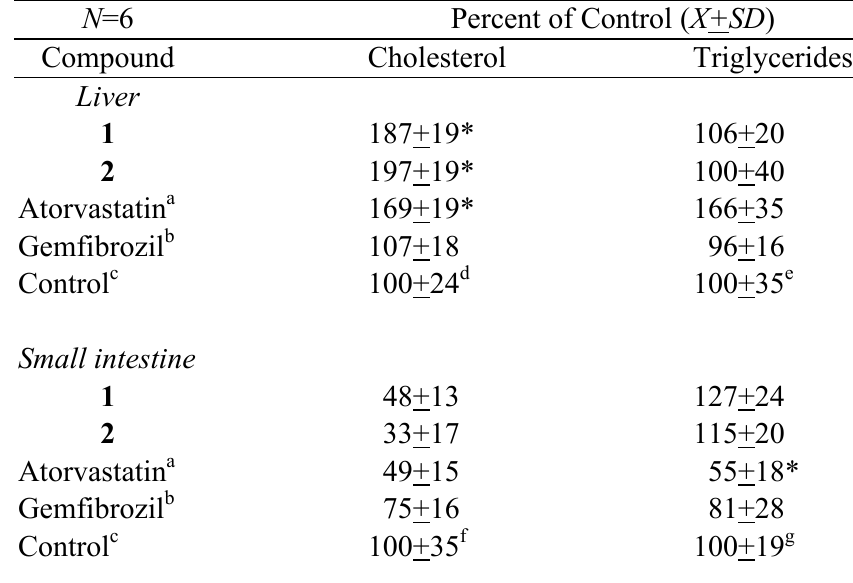
Table 3: The effects of the 2,3,4-trisubstituted pyrroles ( 1 ) and ( 2 ) in Sprague-Dawley Rats at 2 mg/kg/day orally for 14 days on tissue lipid